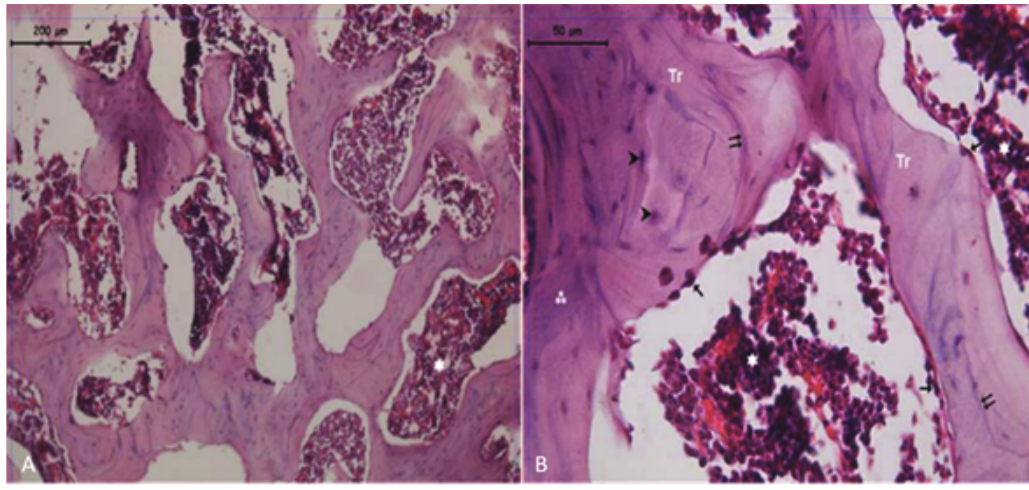
Figure 4: Microscopic view of the femoral neck in the diabetic group exposed to rosiglitazone. Tr: trabeculae; *Bone marrow tissue; ◊ Irregular bone trabeculae; Basophilic bone sites. Arrowhead: Osteocyte; Arrow: Osteoblast